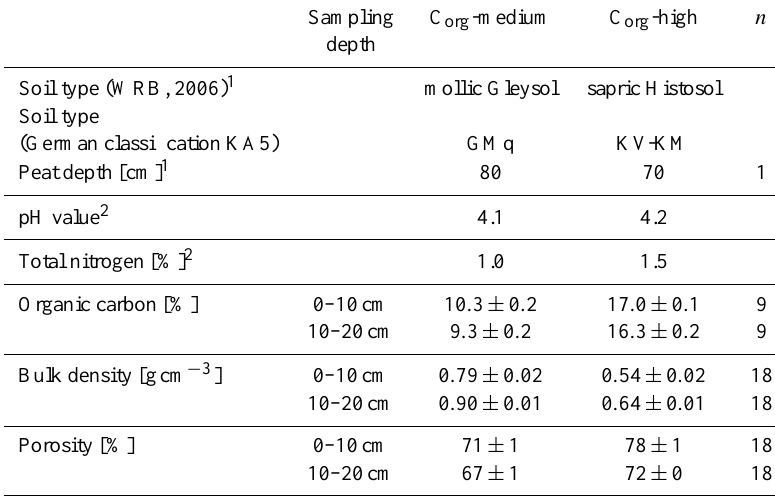
Table 2. Soil properties of the study